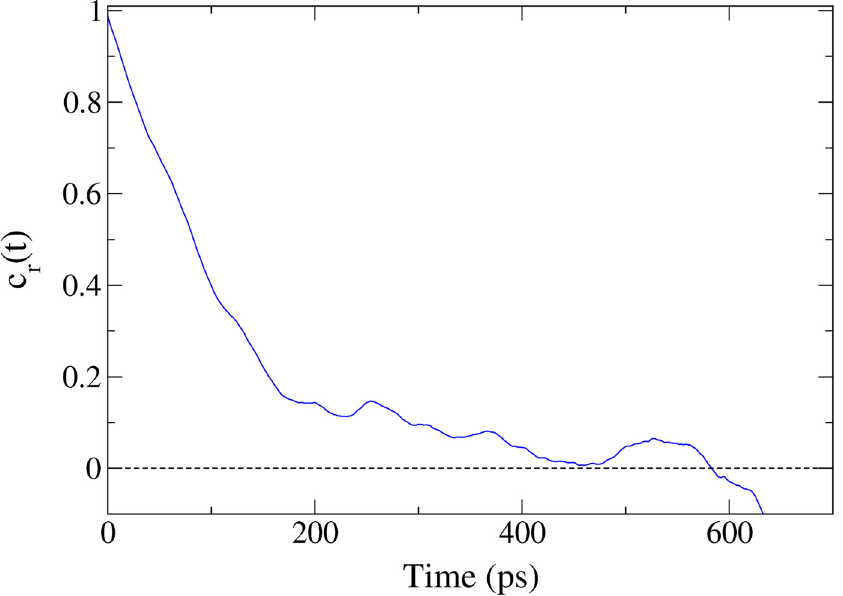
^r ð t Þ (cid:4) ^r ð 0 Þi , of tyr + with the COM constrained at * 10